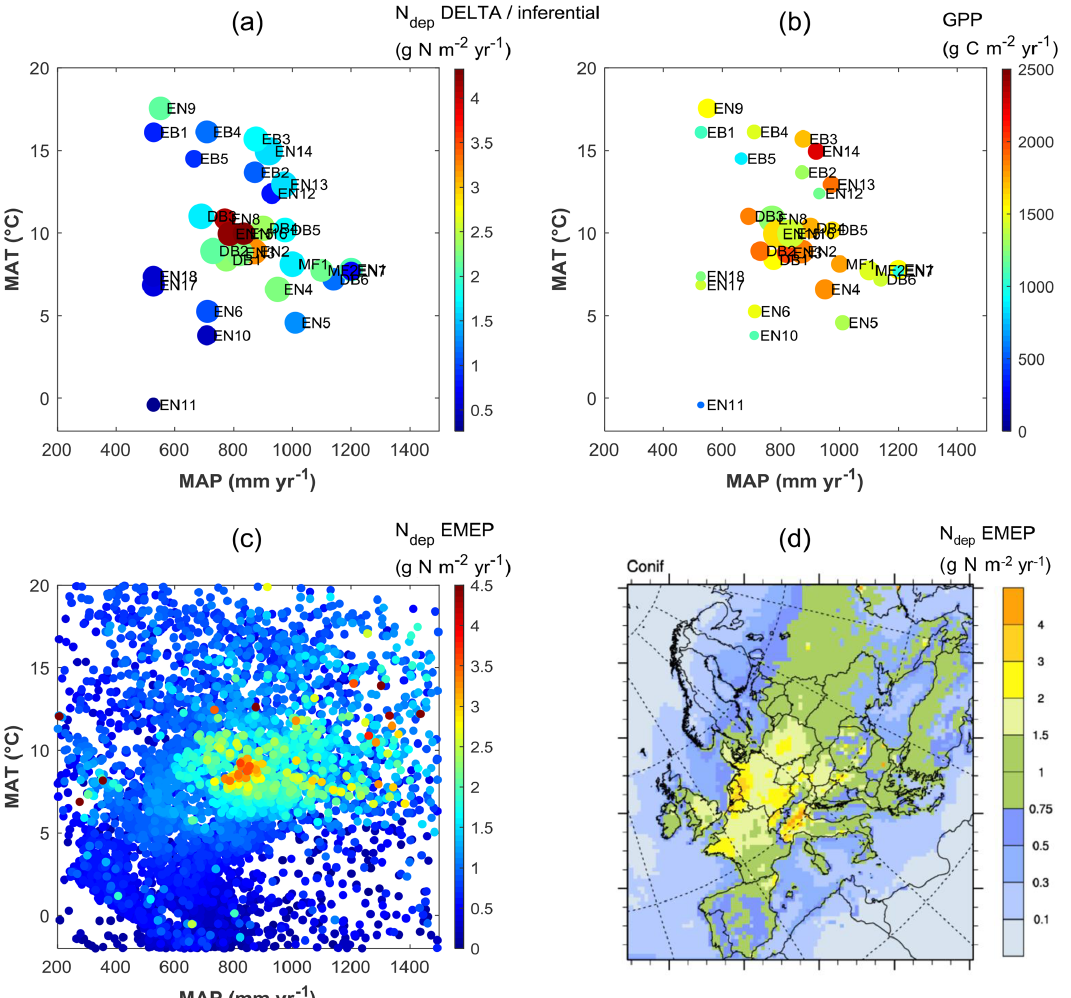
Figure 5. Distribution of observation-based nitrogen deposition ( N dep ) (a) and gross primary productivity (GPP) (b) for the forest sites of this study, within the European climate space represented by mean annual temperature (MAT) and precipitation (MAP). In plot (a) the symbol colour indicates N dep , while the symbol size is proportional to GPP; in plot (b) the symbol colour indicates GPP, while the symbol size is proportional to N dep . Plot (c) shows modelled N dep from the EMEP model over coniferous forests (year 2010), represented in climate space (one data point for each grid square of the EMEP domain containing coniferous forests), also shown as a map (d) . The MAT axis can be seen as a proxy for latitude and/or elevation, while the MAP axis expresses to some extent longitude (distance to the ocean) and/or orographic precipitation